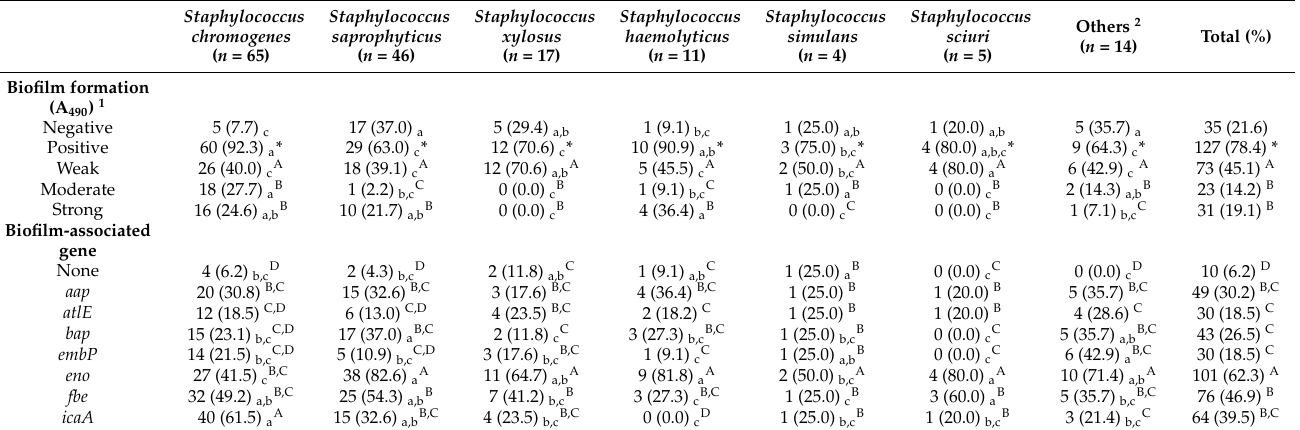
Table 1. Distribution of biofilm formation potential and biofilm-associated genes in 162 coagulase negative staphylococci from milk.